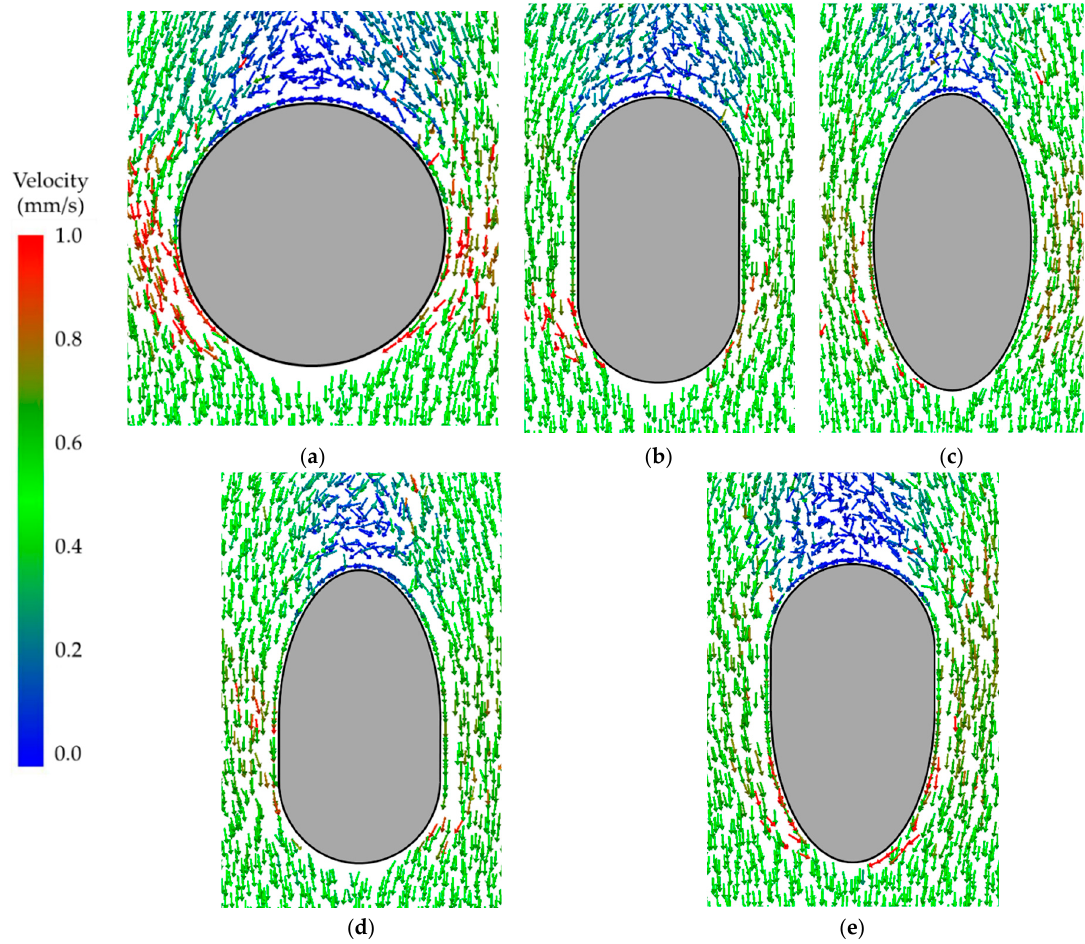
Figure 6. Velocity vector distributions of particle flow around different tubes ( v out = 0.5 mm/s, d p = 1.72 mm): ( a ) Circular tube; ( b ) Flat elliptical tube; ( c ) Elliptical tube; ( d ) Elliptical-Flat elliptical tube; ( e ) Flat elliptical-Elliptical tube.